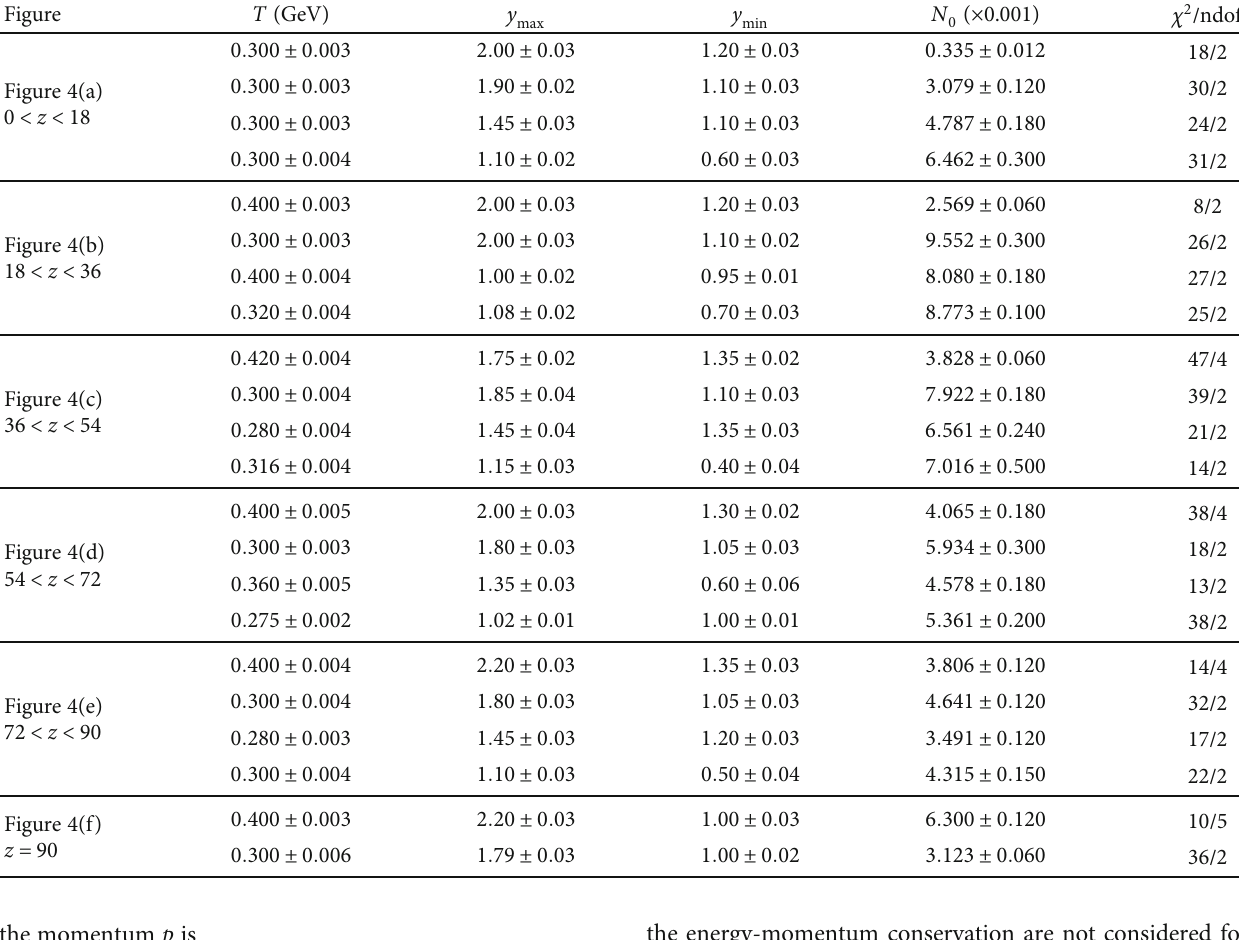
y N χ 2 , and ndof corresponding to the curves in Figure 4 in which di ff erent data are measured in di ff erent θ Table 4: Values of T , y 0 , max , min , and z ranges. In the table, z is in the units of cm and θ is not listed, which appears in Figure 4. Figure Figure 4(a) 0 < z < 18